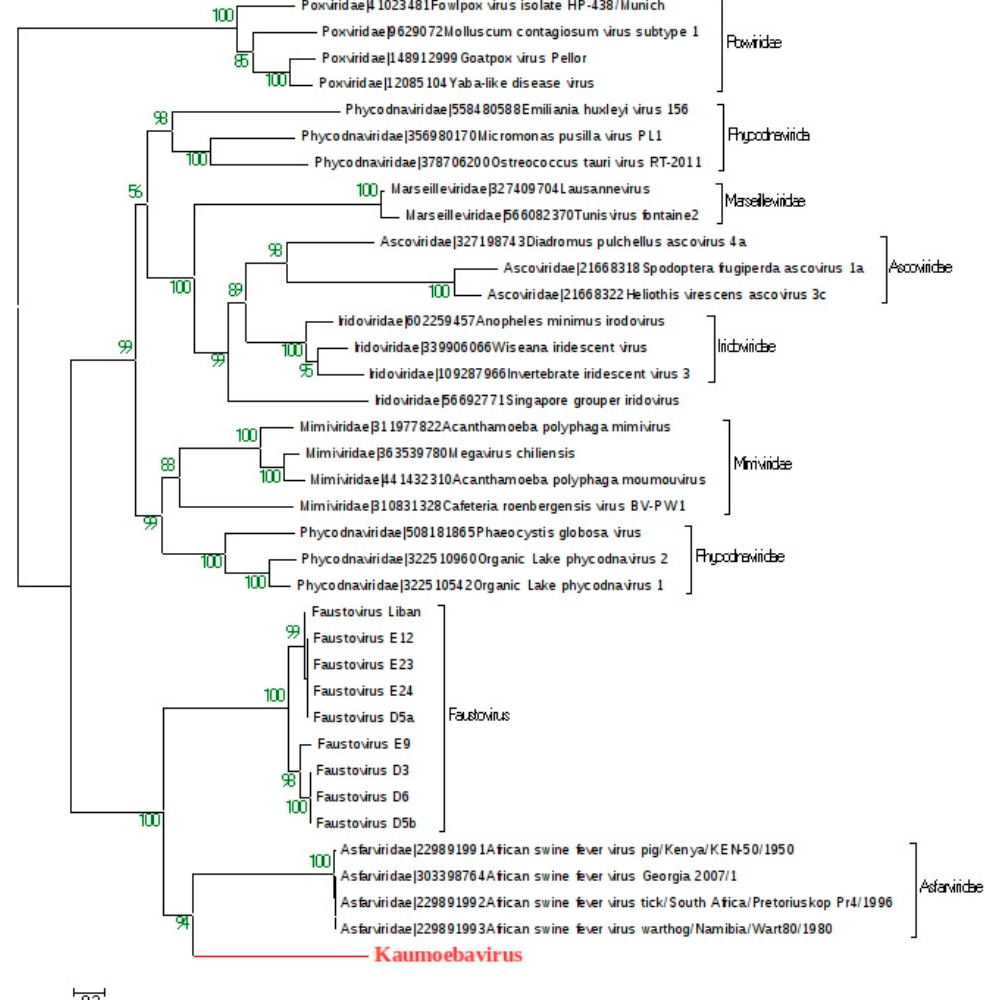
Figure 4. Phylogenetic reconstruction based on a concatenated A32-like packaging ATPase and the family B DNA polymerase. Phylogenetic analysis was performed using the maximum likelihood method based on protein sequences from Kaumoebavirus and representative members from the different families of Megavirales order.